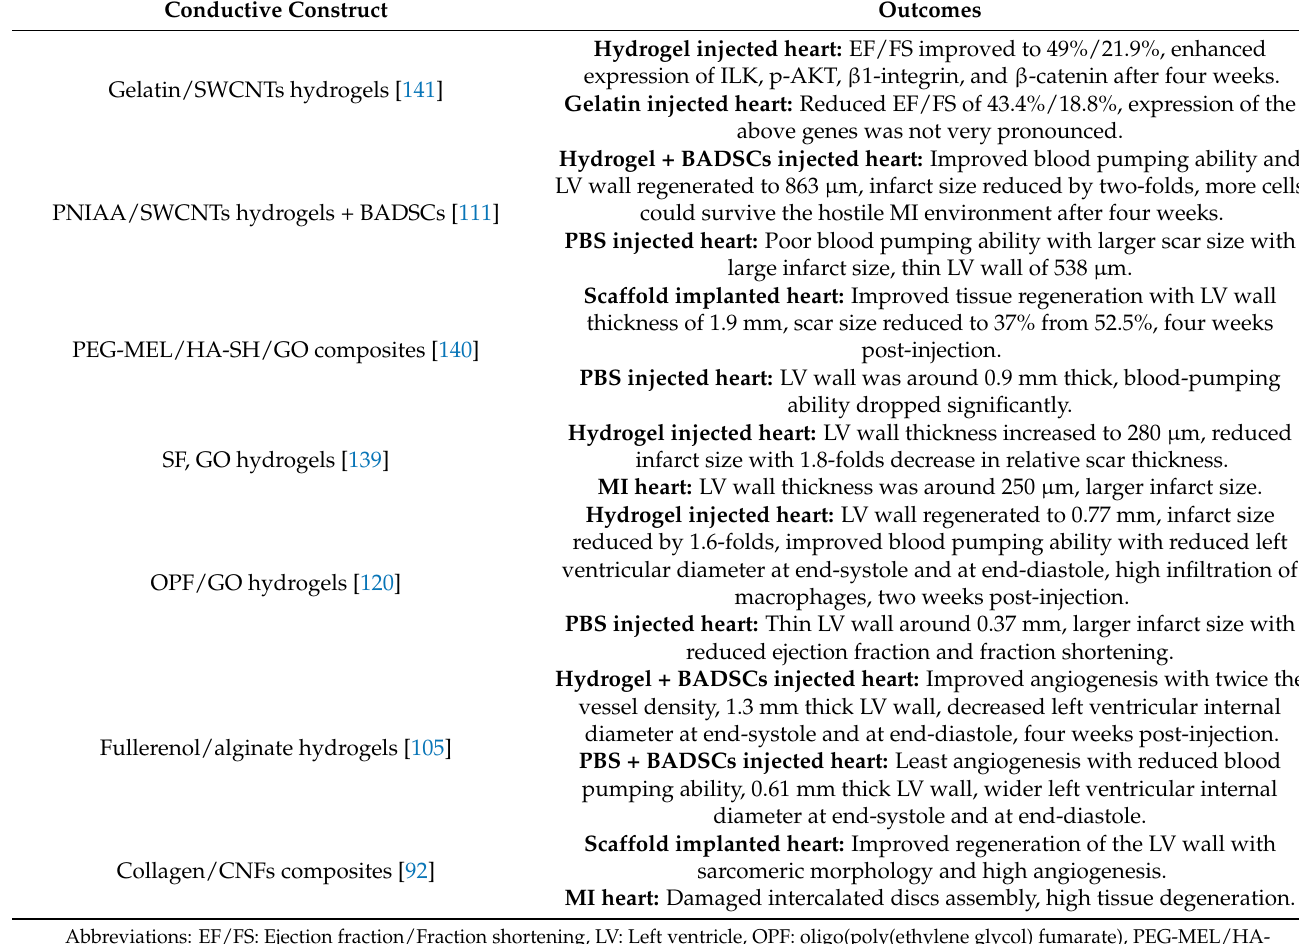
Table 7. Preclinical studies using rat MI models to repair the ischemic tissue. Conductive